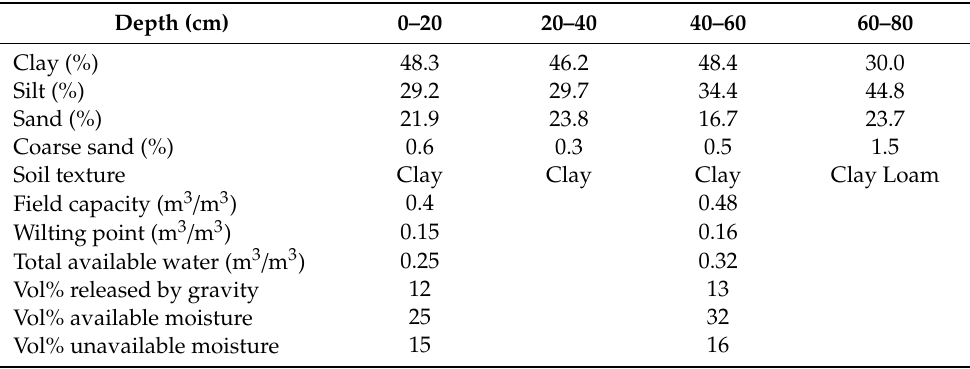
Table 1. Physical soil